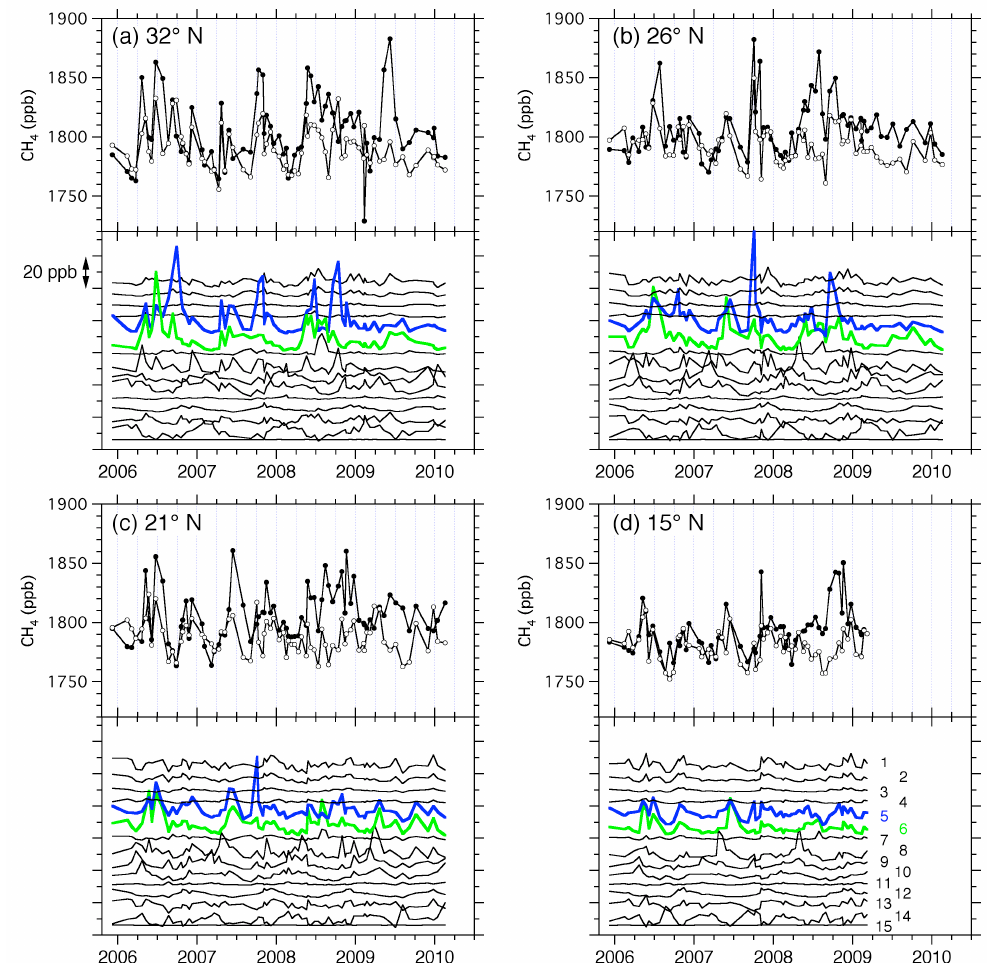
Fig. 6. Comparison of the observed (closed circles) and model-simulated (open circles) CH 4 mixing ratios for the UT at (a) 32 ◦ N. (b) 26 ◦ N, (c) 21 ◦ N and (d) 15 ◦ N. In each lower panel the tagged tracers for the respective regions 1–15 (from top to bottom) are shown. Blue and green lines represent Region 5 (South Asia) and Region 6 (East Asia), respectively, and each line is offset for easy view.